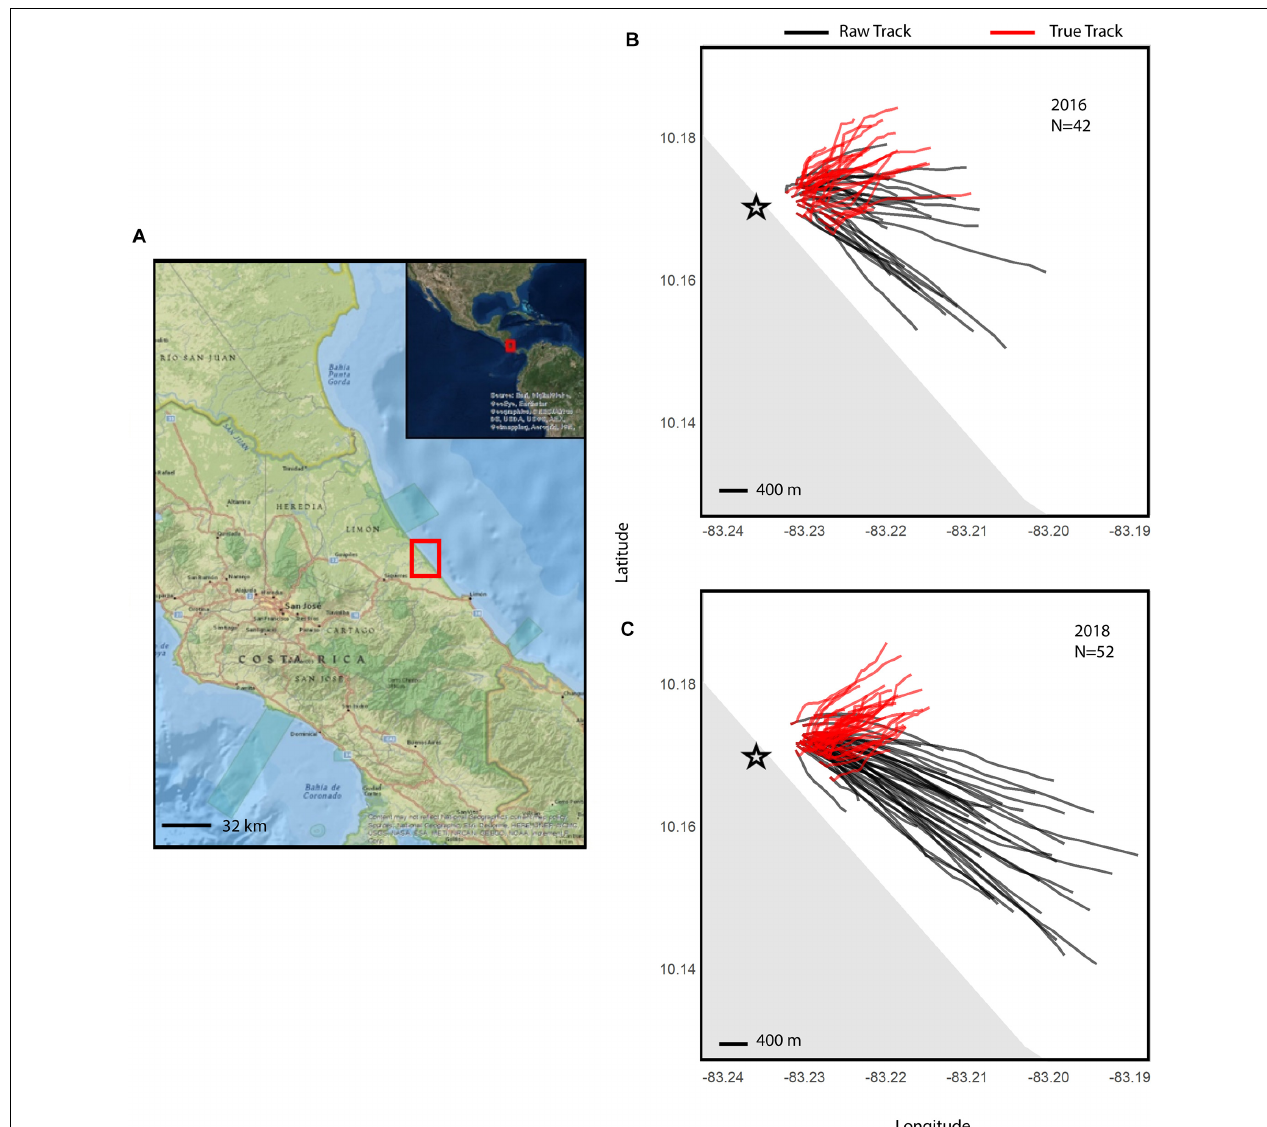
FIGURE 1 | Maps of neonate tracks off the shore of Pacuare Nature Reserve, Costa Rica (A) for 2016 (B) and 2018 (C) , with the reserve location indicated with a red box. Maps of true neonate tracks (red), were plotted using their heading and true swimming speeds, and raw neonate tracks (black). The black star shows the hatchery where turtles would emerge naturally from. The basemaps for this figure were created using ArcGIS R (cid:13) software by Esri. ArcGIS R (cid:13) and ArcMAP TM are the intellectual property of Esri and used under license, copyright © Esri, all rights reserved.